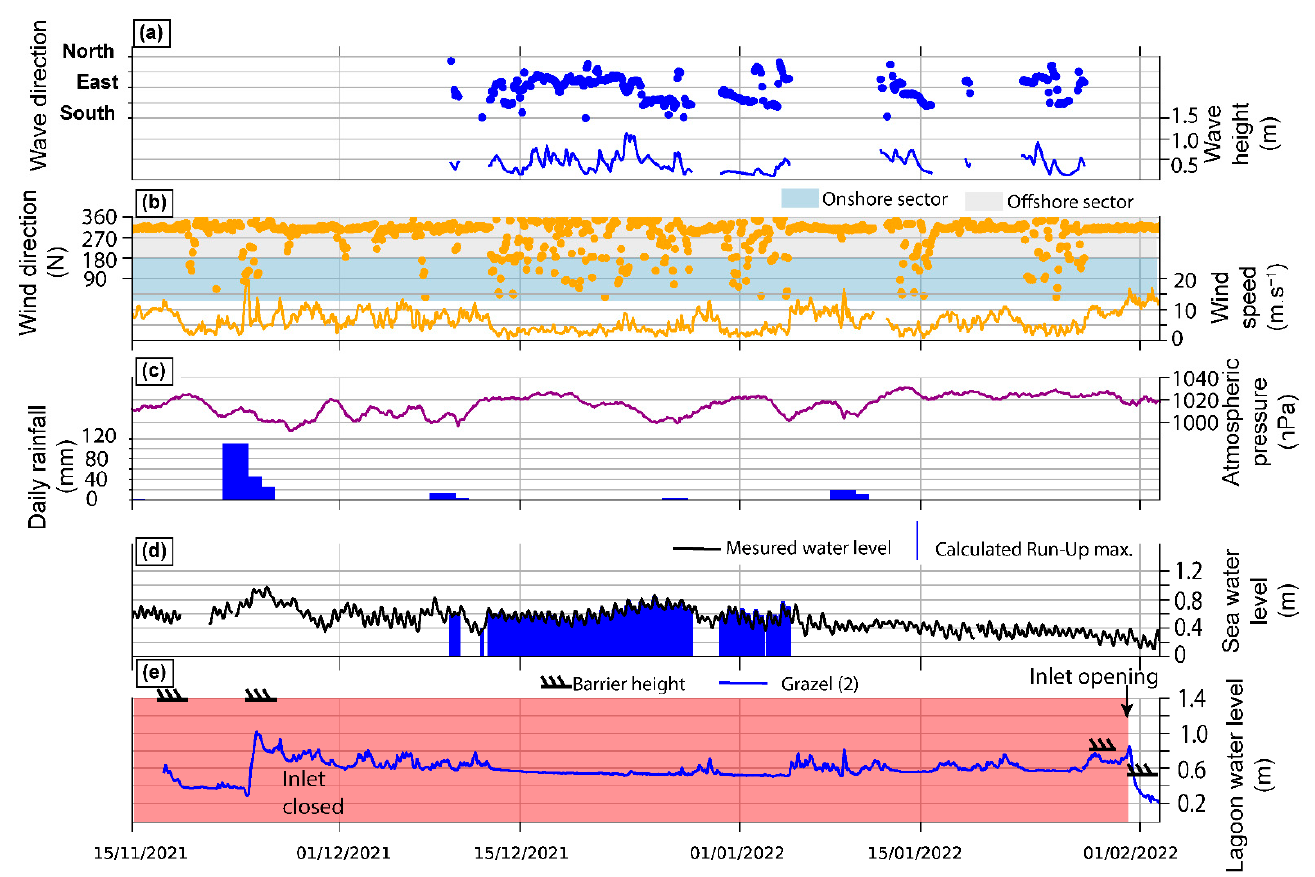
Figure 5. Recorded hourly forcing conditions before and during inlet opening. ( a ) Wave conditions measured at the Leucate buoy (periods of offshore-directed waves are not indicated for sake of clarity); ( b ) Wind conditions; ( c ) Precipitation and atmospheric pressure; ( d ) Seawater levels and run-up values; ( e ) Lagoon water level measured at Grazel (see 2 in Figure 1) and measured barrier height.